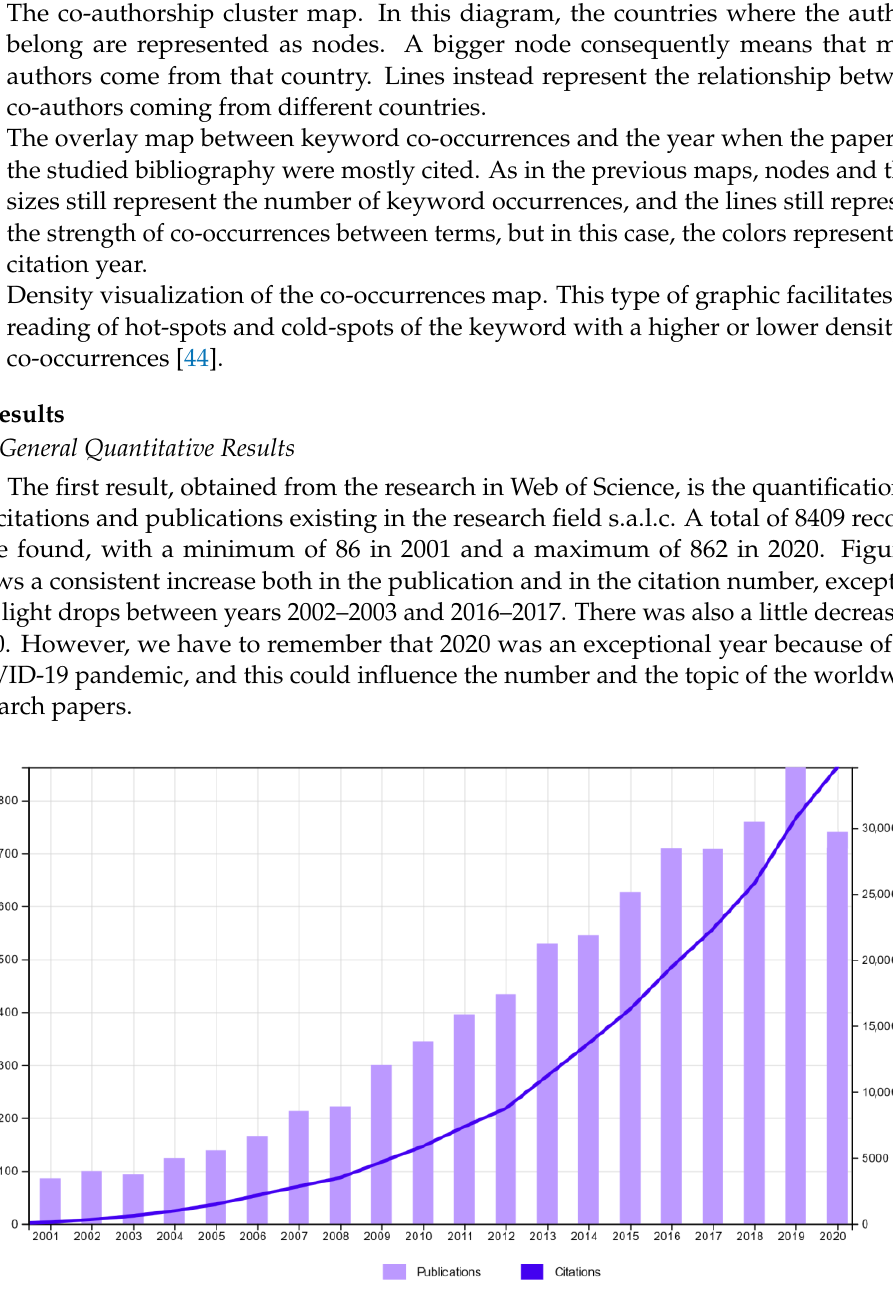
Figure 1. Diagram representing the number of citations and publications reported by Web of Science from 2000 to 2020.